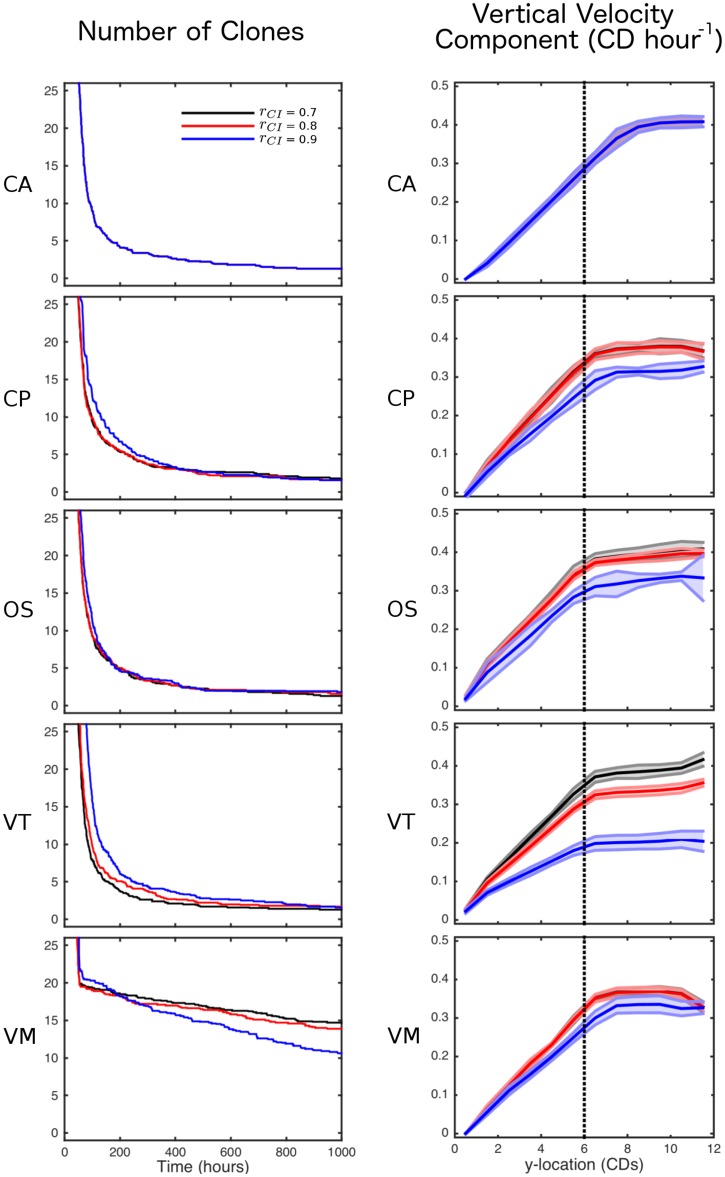
Comparison of clonal population dynamics and cell velocity across crypt simulations for varying levels of contact inhibition.Left: the number of clones remaining in the crypt is computed as a function of time for each model: CA; CP; OS; VT; and VM. Right: the vertical component of cell velocity is computed for each model. For each model, the mean and standard error (not shown on clonal plots for clarity) from 10 simulations are shown for three levels of contact inhibition, quantified by the parameter rCI. The vertical dotted line corresponds to the height of the proliferative compartment, yprolif. Parameter values are given in Tables 1 and 3.